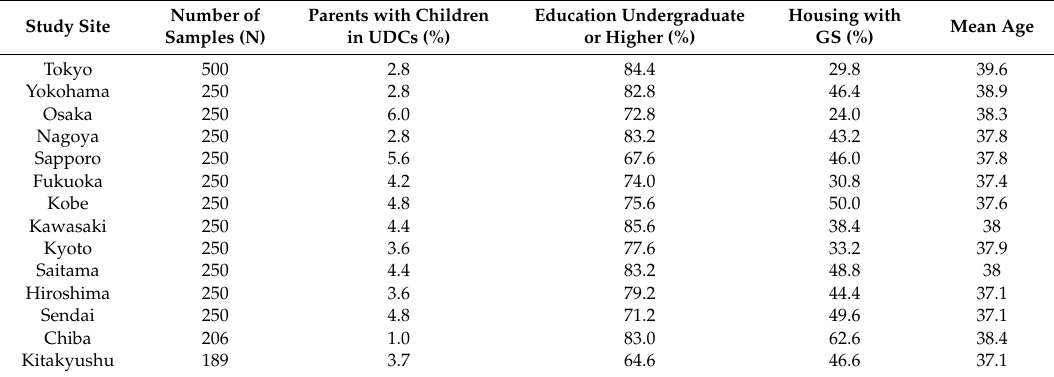
Table 7. Characteristics of surveyed